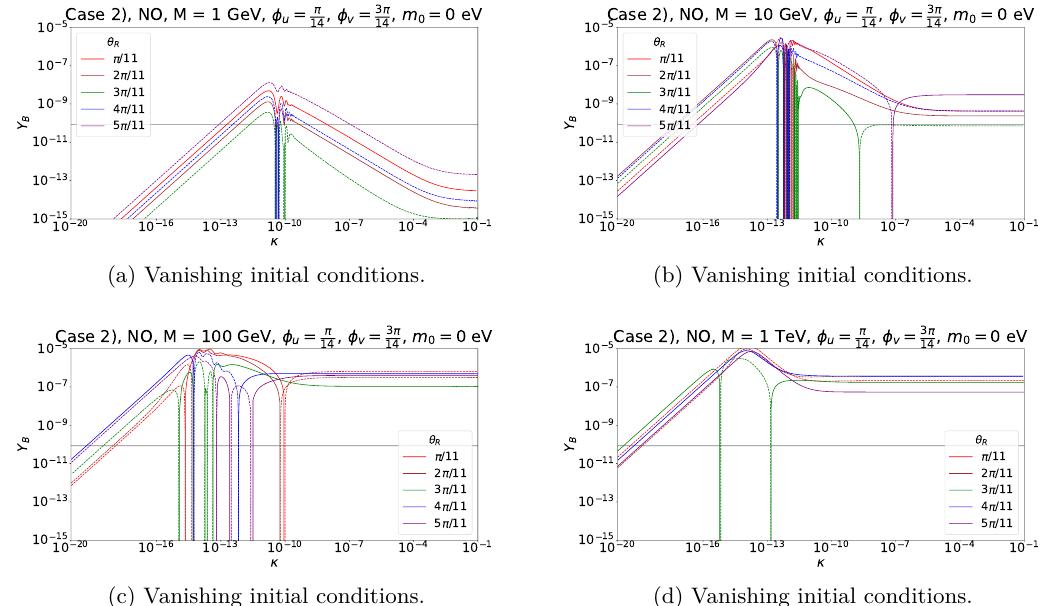
Figure 16 . Case 2) Y B as function of κ for a Majorana mass M = 1 GeV (upper left plot), M = 10 GeV (upper right plot), M = 100 GeV (lower left plot) and M = 1 TeV (lower right plot). For each of these choices, different values of θ have been studied. The parameters ( s, t ) have been R fixed to (1 , 1) which corresponds to φ = π and φ = 3 π . Light neutrino masses have strong NO. u v 14 14 Both negative (dashed lines) as well as positive (continuous lines) values of the BAU are represented. The grey line indicates the observed value of the BAU, Y 8 . 6 · 10 − 11 . The large number of B ≈ oscillations around κ ≈ 10 − 12 to 10 − 11 in plot (b) is an artefact of the momentum averaged set of equations, see eq. (5.1), used in this work. Explicitly including the momentum dependence would remove these, see